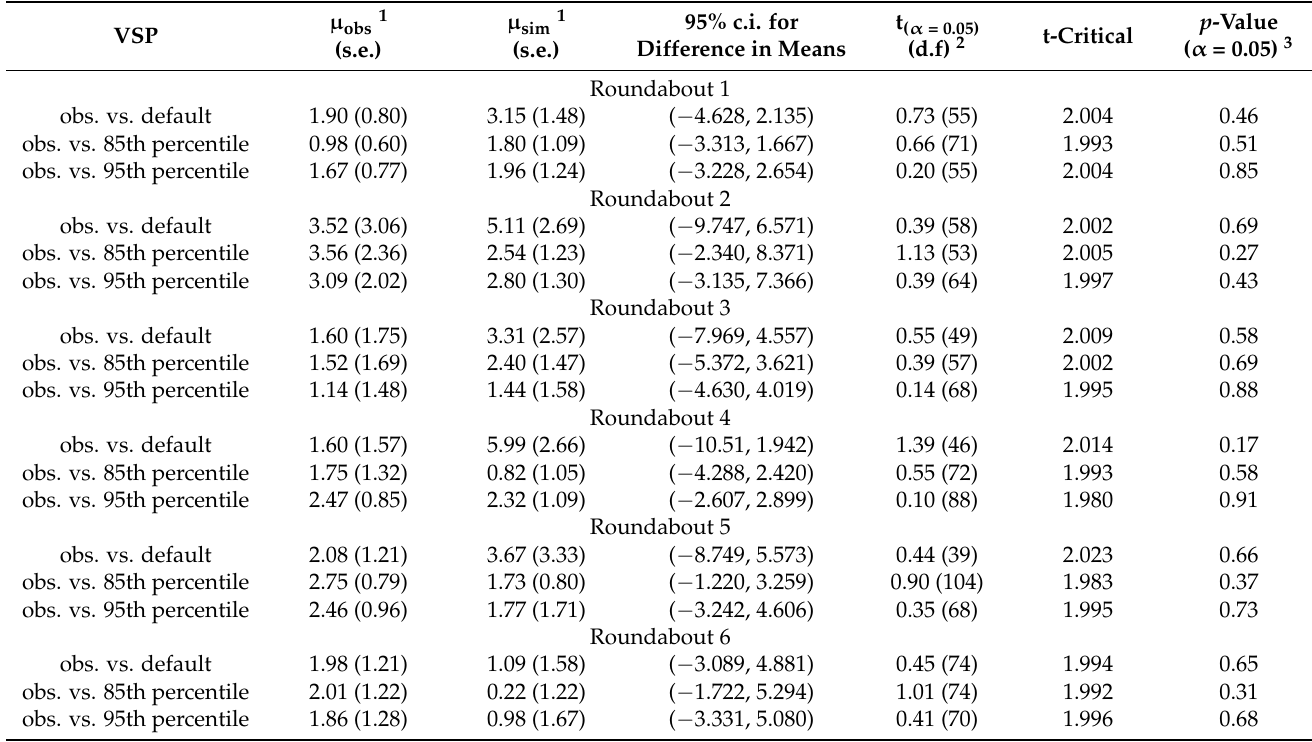
Table 5. The results of the two-sample t -test for the observed vs. simulated VSP distributions for the sampled roundabouts (direction AB in Figure 2).